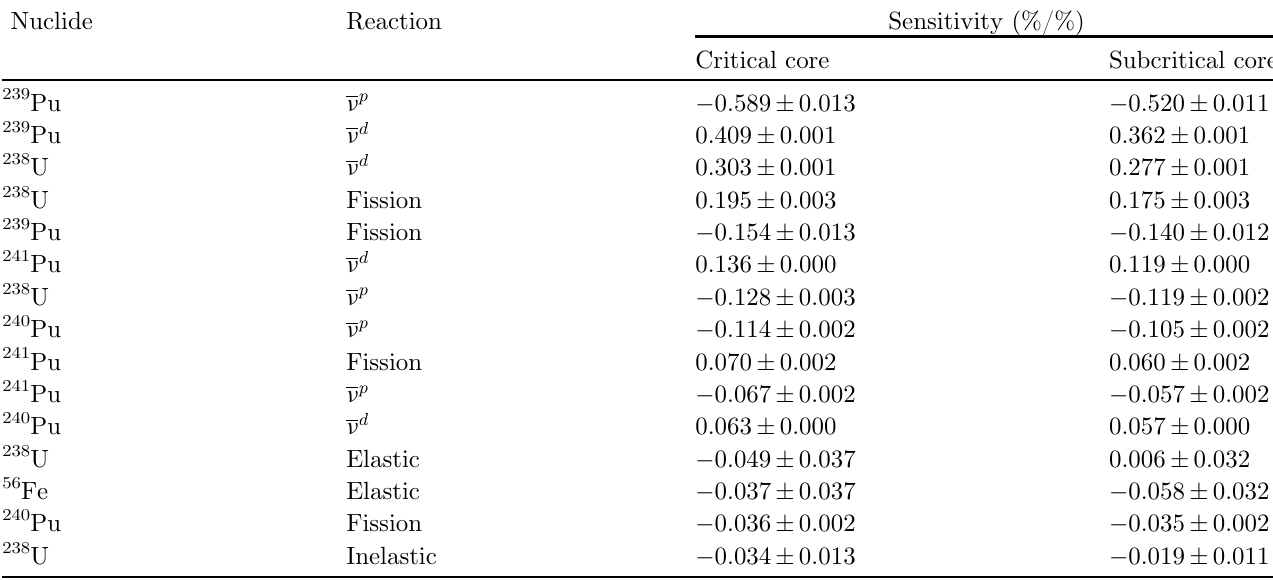
Table 1. Major b sensitivities with 1 s statistical uncertainities ( a = 20, top 15). eff